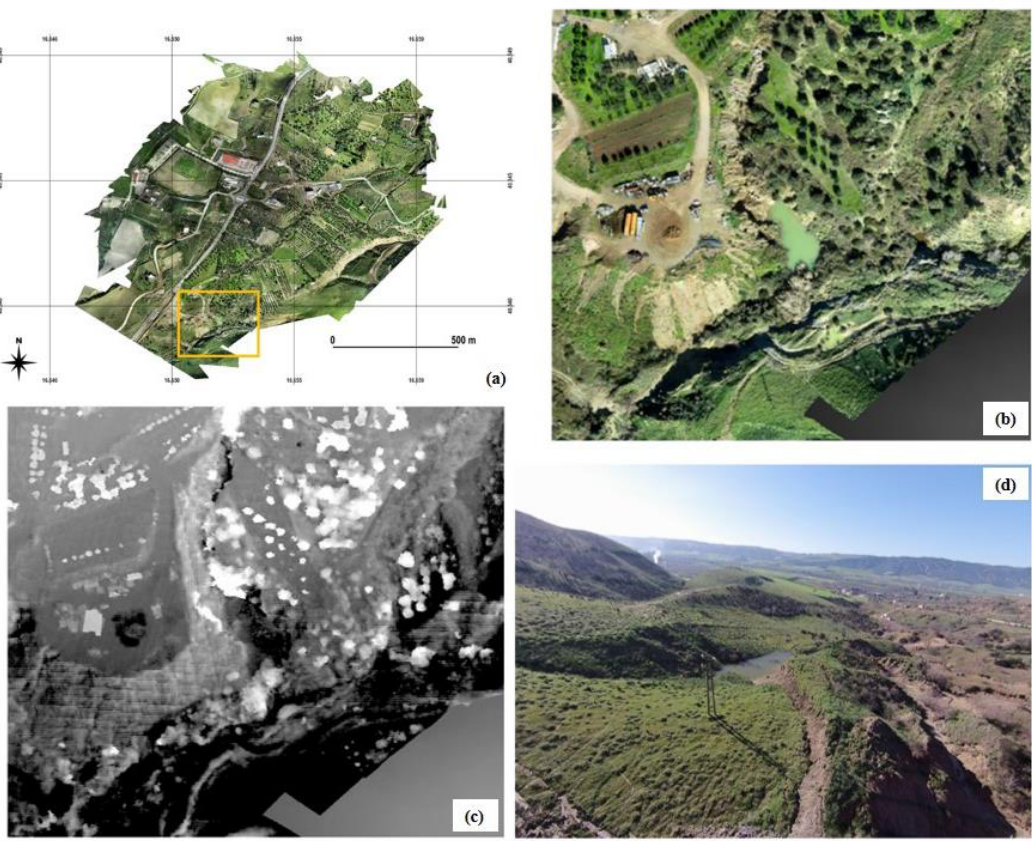
Figure 8. Detail at the landslide toe of the orthophoto realized by UAV (yellow frame) ( a ), zoom image from a photo ( b ), zoom of the image difference between DSM-UAV altimetric and LiDAR-DTM ( c ), and panoramic view ( d ).